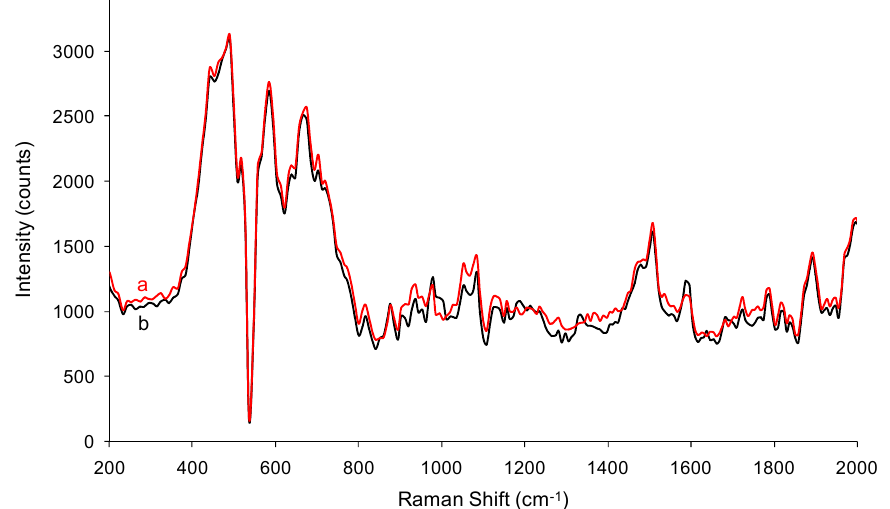
Figure 7. Raman spectra of ZnO NPs obtained without PyQAs1 ( a ) and with 5% PyQAs1 ( b ).